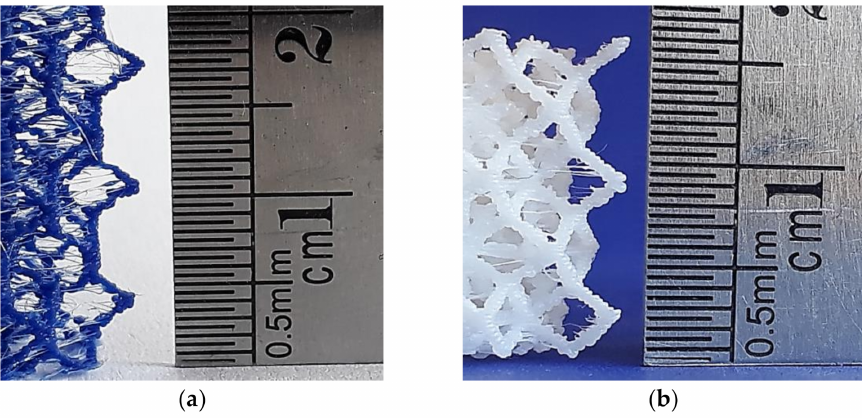
Figure 13. Detail of two TV lattice structures printed using different printers at a 1:1 scale: ( a ) TV lattice printed in Ender 3 (PLA); ( b ) TV lattice printed in Up mini 2 (ABS).